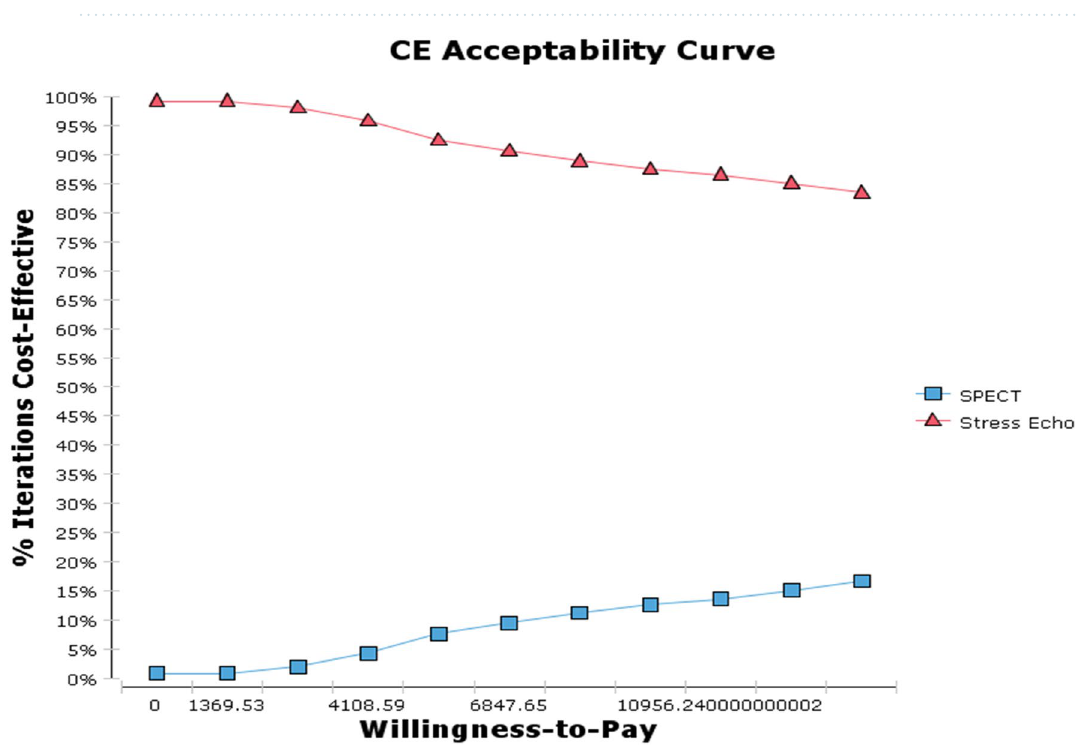
Figure 5. Cost-effectiveness acceptability